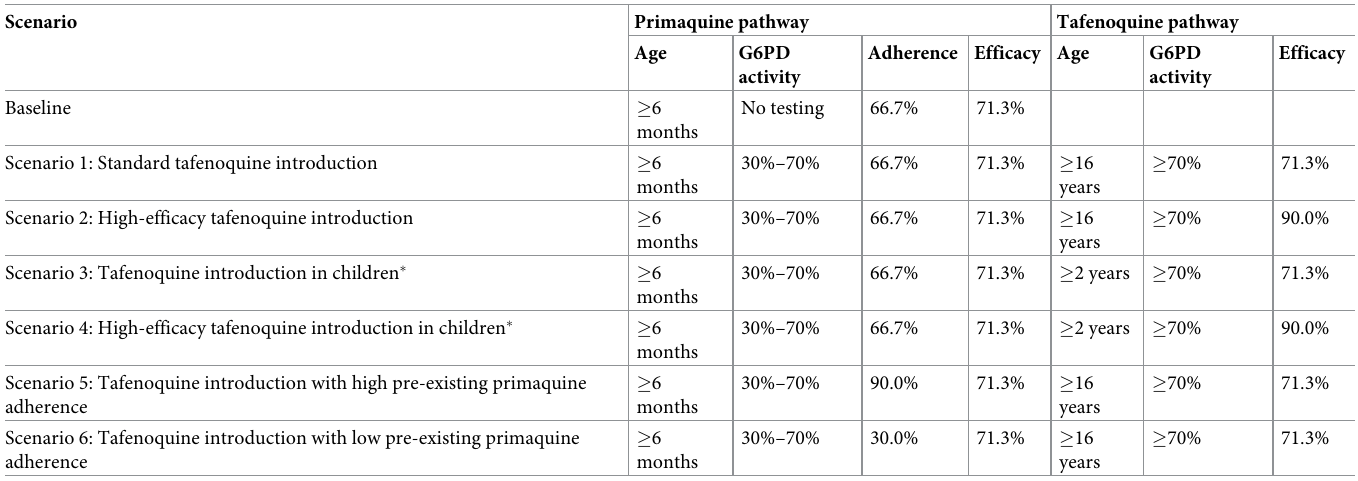
Table 2 AU : InTable 2 ; Iassumedthemissingdecimalplacevaluesfortheadherenceandefficacyvalues 30 and 90 were 30 : 0 and 90 : 0 : Ifthisisnotcorrect ; pleaseedit : . Tafenoquine AU : Ieditedthetermyoungchildreninscenario 3 inTables 2 (cid:0) 4 tojustchildren ; tomatchthewordingusedforscenario 4 ð andforscenario 3 and 4 inFig 2 Þ : introduction scenarios.